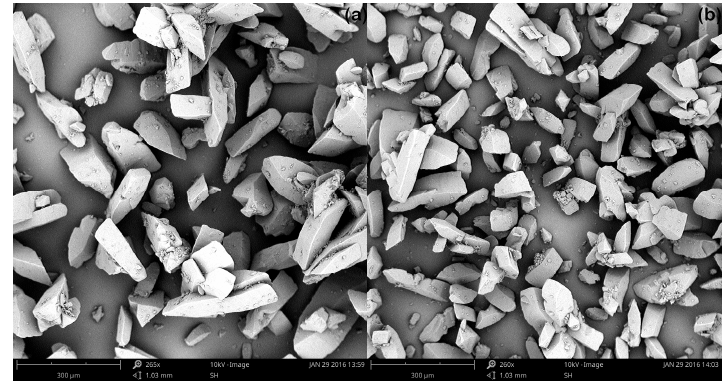
Figure 5. Effect of seed mass on degree of agglomeration, while operating at a constant stirring rate of 250 rpm and seeding temperature of 62 °C: ( a ) 1 m% seed mass; and ( b ) 5 m% seed mass. These SEM images were magnified 265 and 260 times, respectively, and the scale bar represents a length of 300 µm.